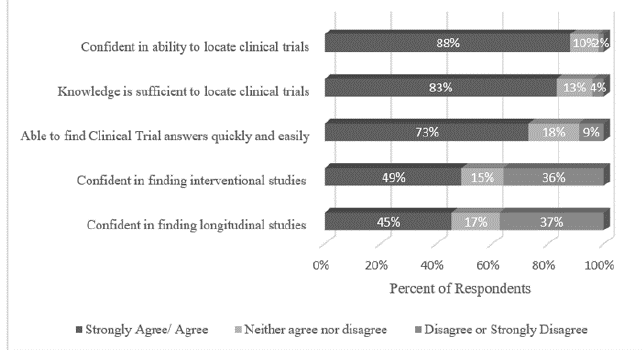
Figure 3 Confidence levels for locating clinical